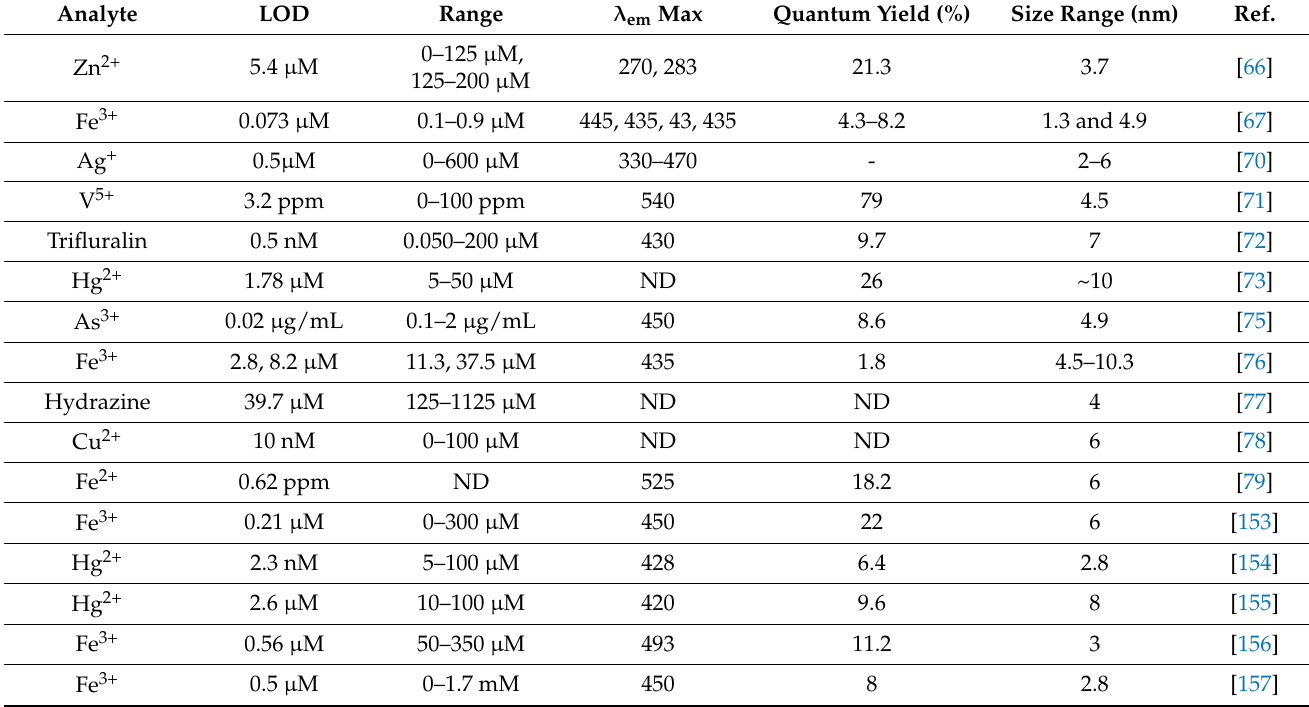
Table 3. Different examples of biosensor application of CQDs and